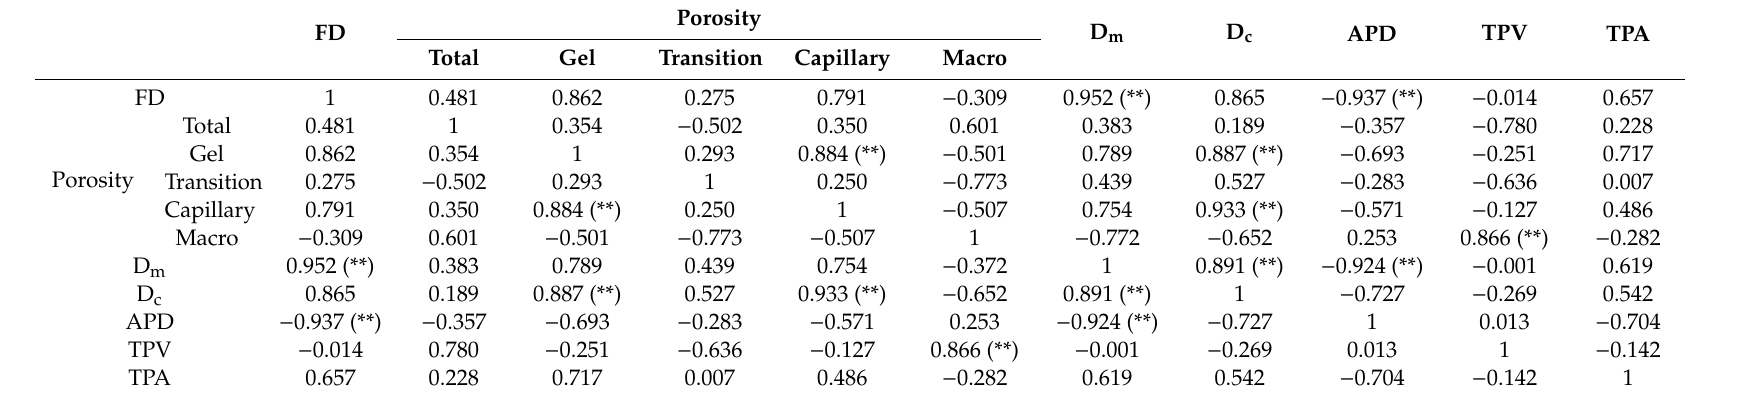
Table 6. Correlation analysis results among pore